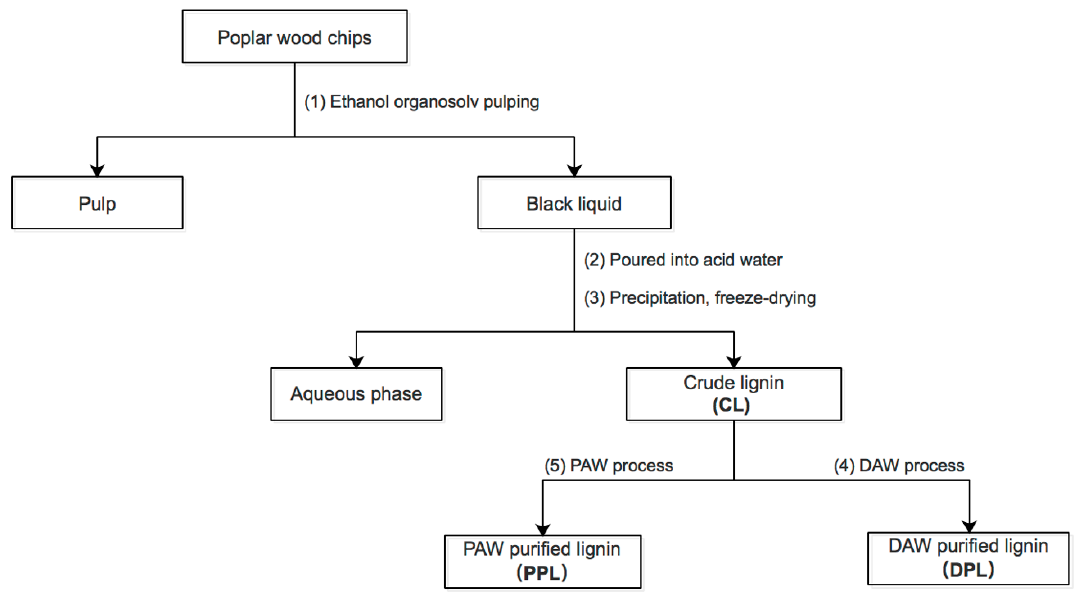
Figure 1. Sequential lignin Figure 1 . Sequential lignin samples.